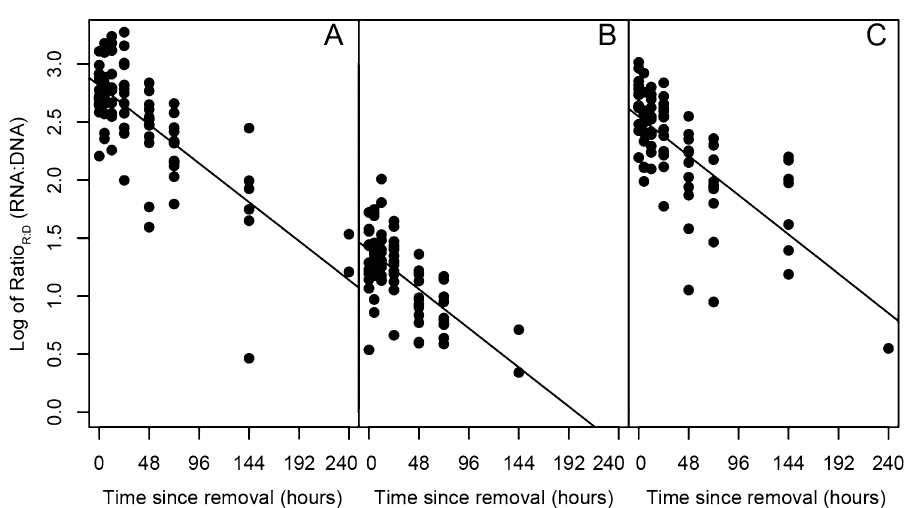
Figure 5. Temporal changes in log 10 Ratio R:D (RNA:DNA) for ( A ) 16S mitochondrial (mt) ribosomal (r)RNA ( p < 0.001***, R 2 = 0.54), ( B ) COI mitochondrial (mt) messenger (m)RNA ( p < 0.001***, R 2 = 0.40), and ( C ) 18S nuclear (nu) rRNA ( p < 0.001***, R 2 =